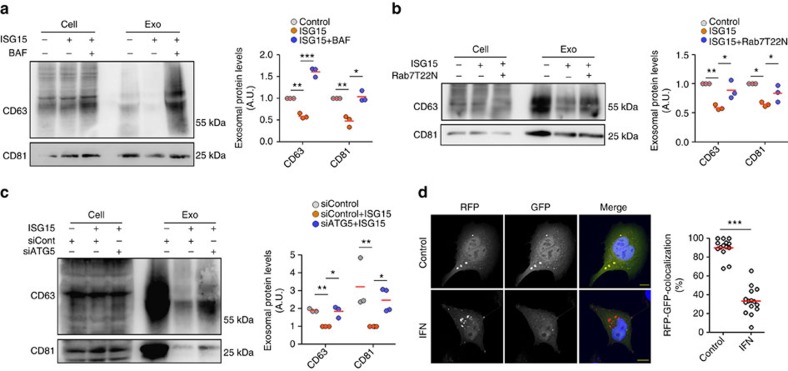
Inhibition of lysosome function upon ISGylation induction rescues exosome secretion.(a) Western blot analysis of exosome secretion in untransfected HEK293 cells and HEK293 cells co-transfected with plasmids encoding the ISGylation machinery and ISG15, and treated with Bafilomycin A1 (BAF), when indicated. Cells and EVs (Exo) were blotted for CD63 and CD81. Right graph: quantification of exosomal protein levels in three independent experiments. (b) Western blot analysis of exosome secretion in HEK293 cells transfected with GFP or co-transfected with plasmids encoding ISG15 and the ISGylation machinery, and when indicated, with the Rab7T22N dominant-negative mutant. Cells and EVs were blotted for CD63 and CD81. Right graph: quantification of exosomal protein levels in three independent experiments. (c) Western blot analysis of exosome secretion in HEK293 cells transfected with control small interfering RNAs (siRNAs) or siRNAs targeting ATG5. After 48 h, cells were re-transfected with siRNAs together with plasmids encoding ISG15 and ISGylation machinery. Cells and EVs (Exo) were blotted for CD63 and CD81. Right: quantification of exosomal protein levels in three or four independent experiments. (d) Confocal analysis of LC3 localization into acidic compartments in HEK293 cells transfected with LC3-RFP-GFP tandem plasmid and treated 16 h with IFN-I where indicated. Nuclei were stained with DAPI. Scale bar, 10 μm. Images were processed by ImageJ and the number of RFP+ and RFP+GFP+ dots quantified. Each dot represents the percentage of RFP+GFP+ dots per individual cell and mean is indicated in red lines; t-test; ***P-value<0.001. Data a,b,c: analysis of variance; *P-value<0.05, **P-value<0.001 and ***P-value<0.0001.